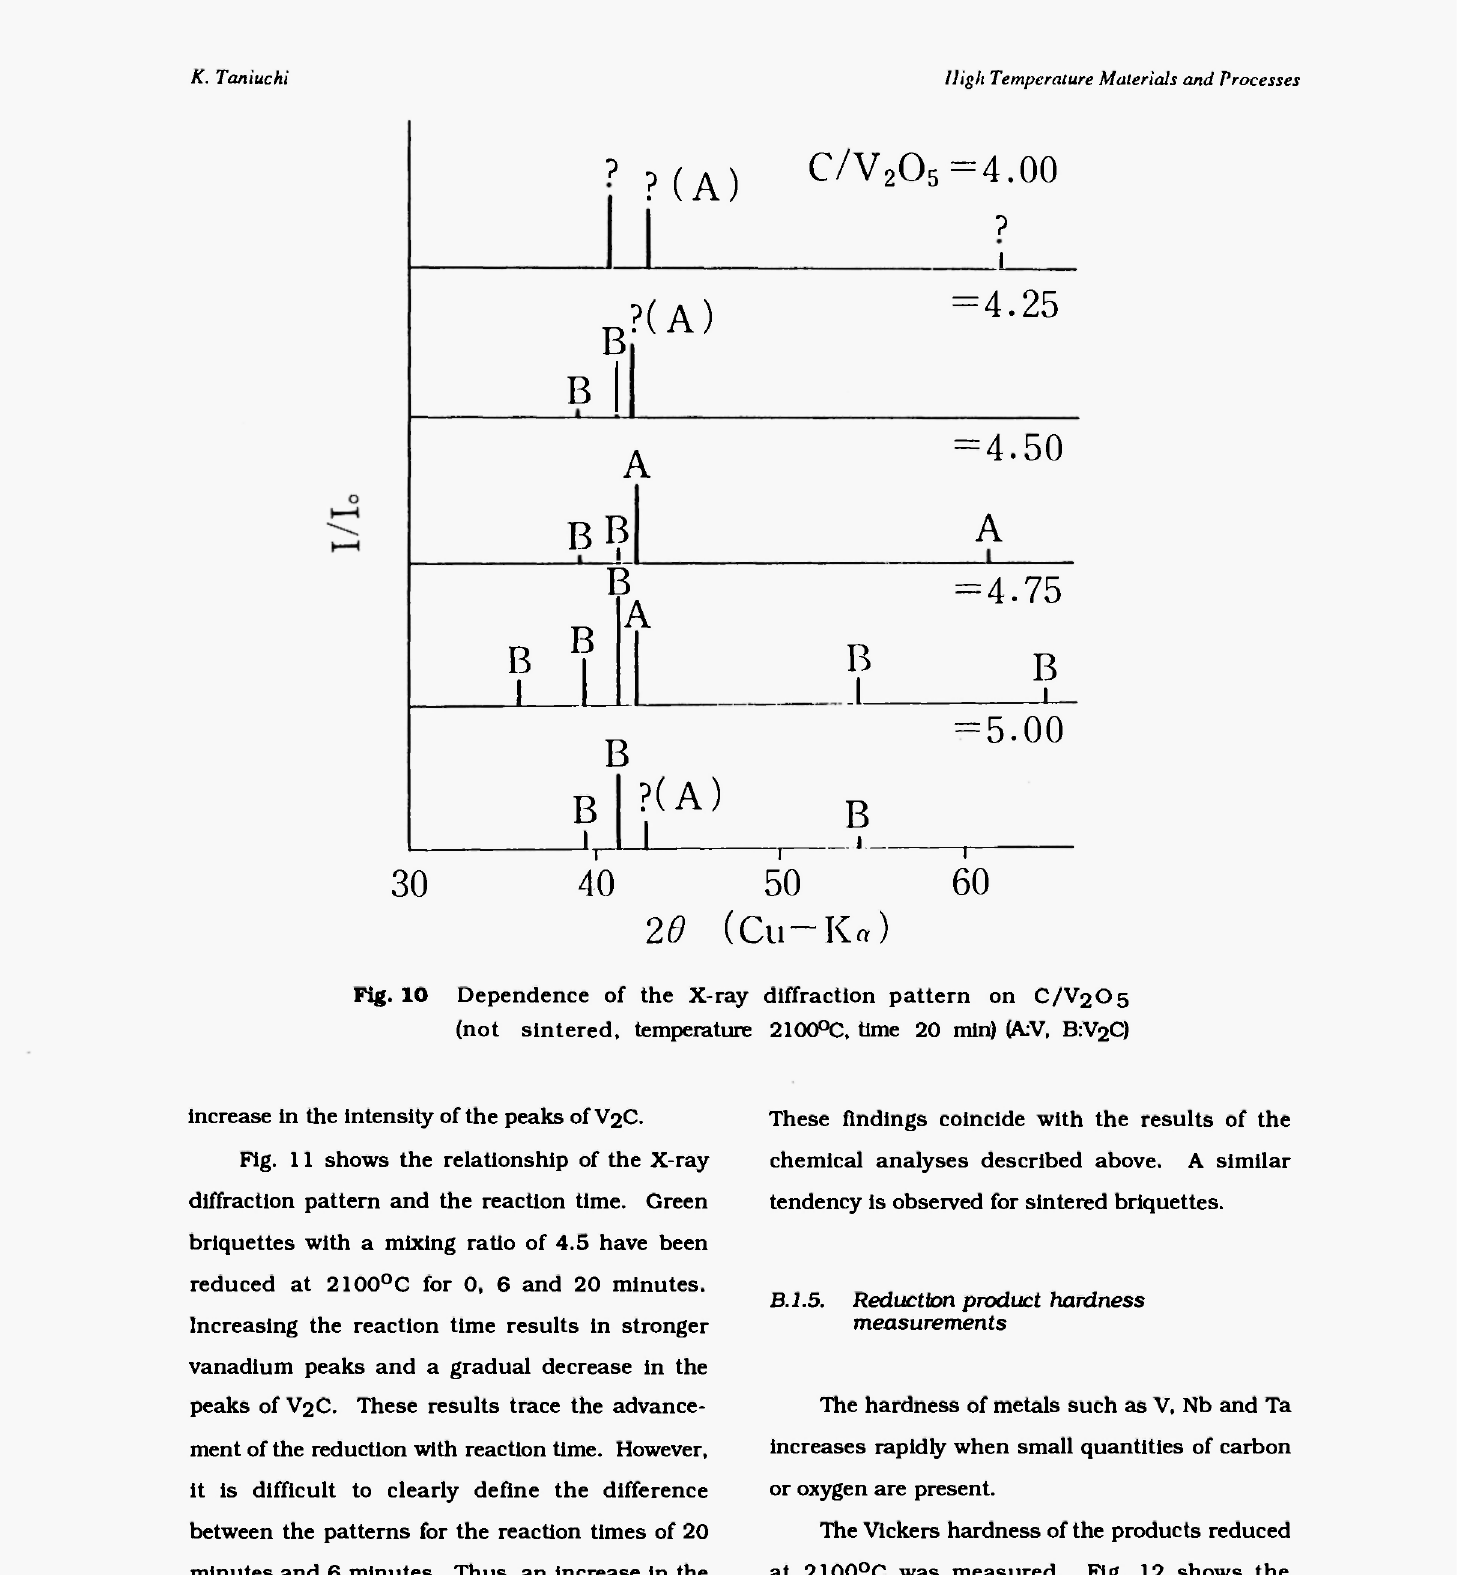
Fig. 10 Dependence of the X-ray diffraction pattern on C/V2O5 (not sintered, temperature 2100°C, time 20 min) (A:V,